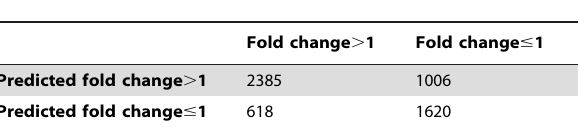
Fold change . 1 Fold change # 1 Predicted fold change . 1